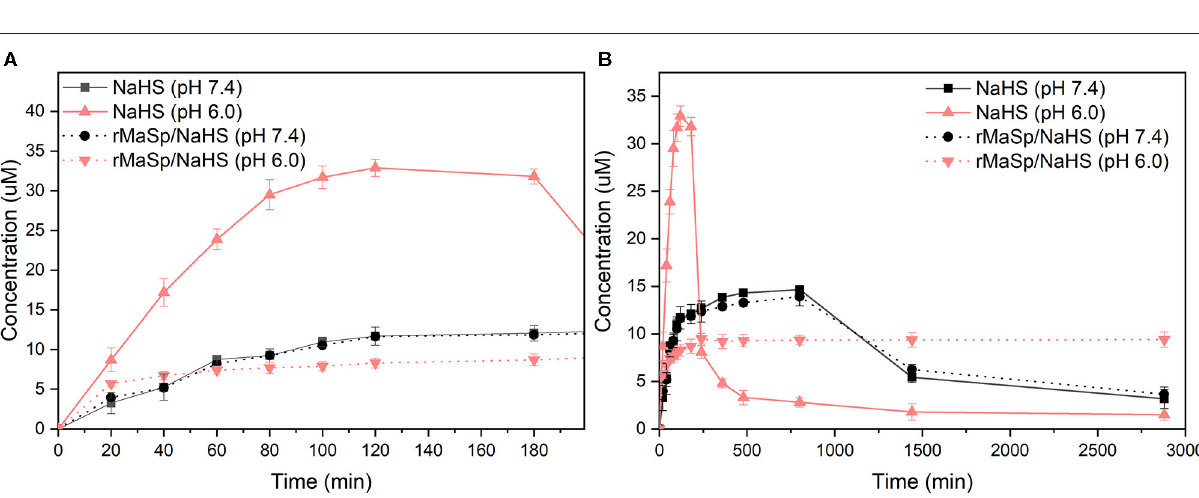
Sirius Red diluted in saturated picric acid was added for 1 h. Then the unbinding Sirius Red was washed with 200 µ L of 0.1 N HCl. Sirius Red on the well bases was then removed by dilution with 200 µ L of 0.5 N NaOH. The tissue slides were observed at 550